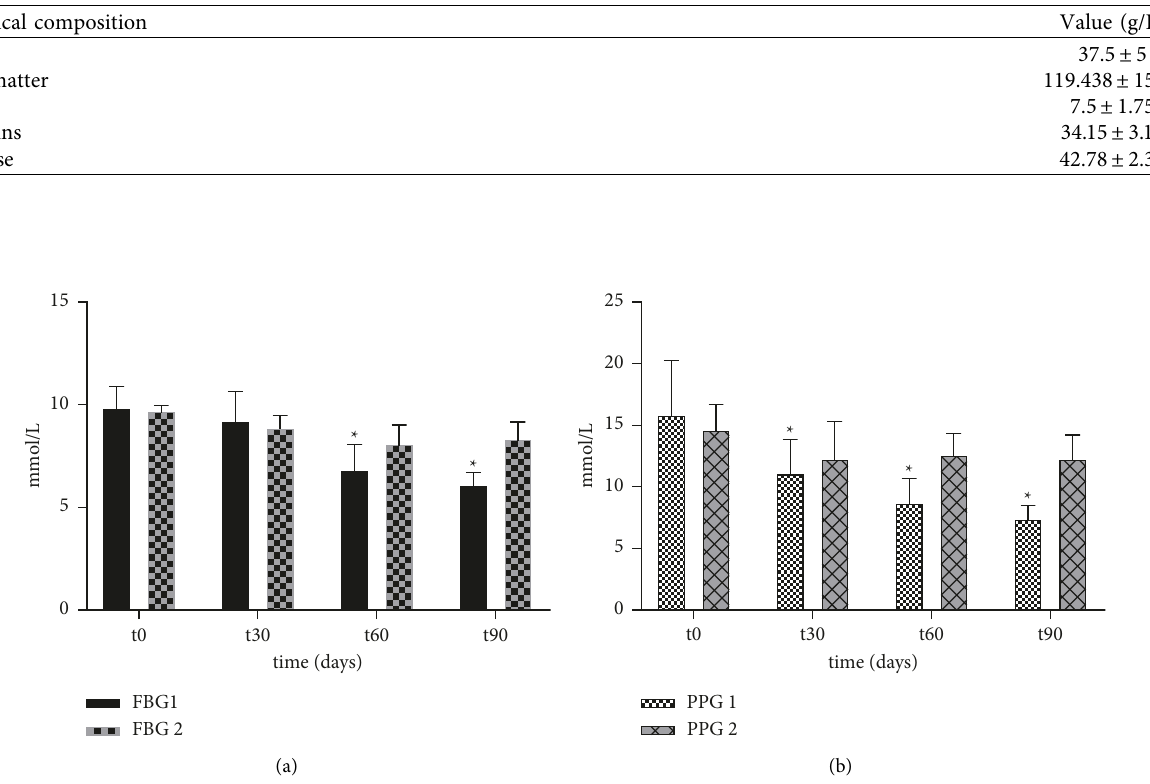
Figure 2: Blood glucose variations during camel milk treatment. (a) Fast blood glucose variations; (b) Postprandial glucose variations. FBG1: fasting blood glucose in group 1; FBG2: fasting blood glucose in group 2. PPG: postprandial glucose (1: diabetic+camel milk, 2: diabetic